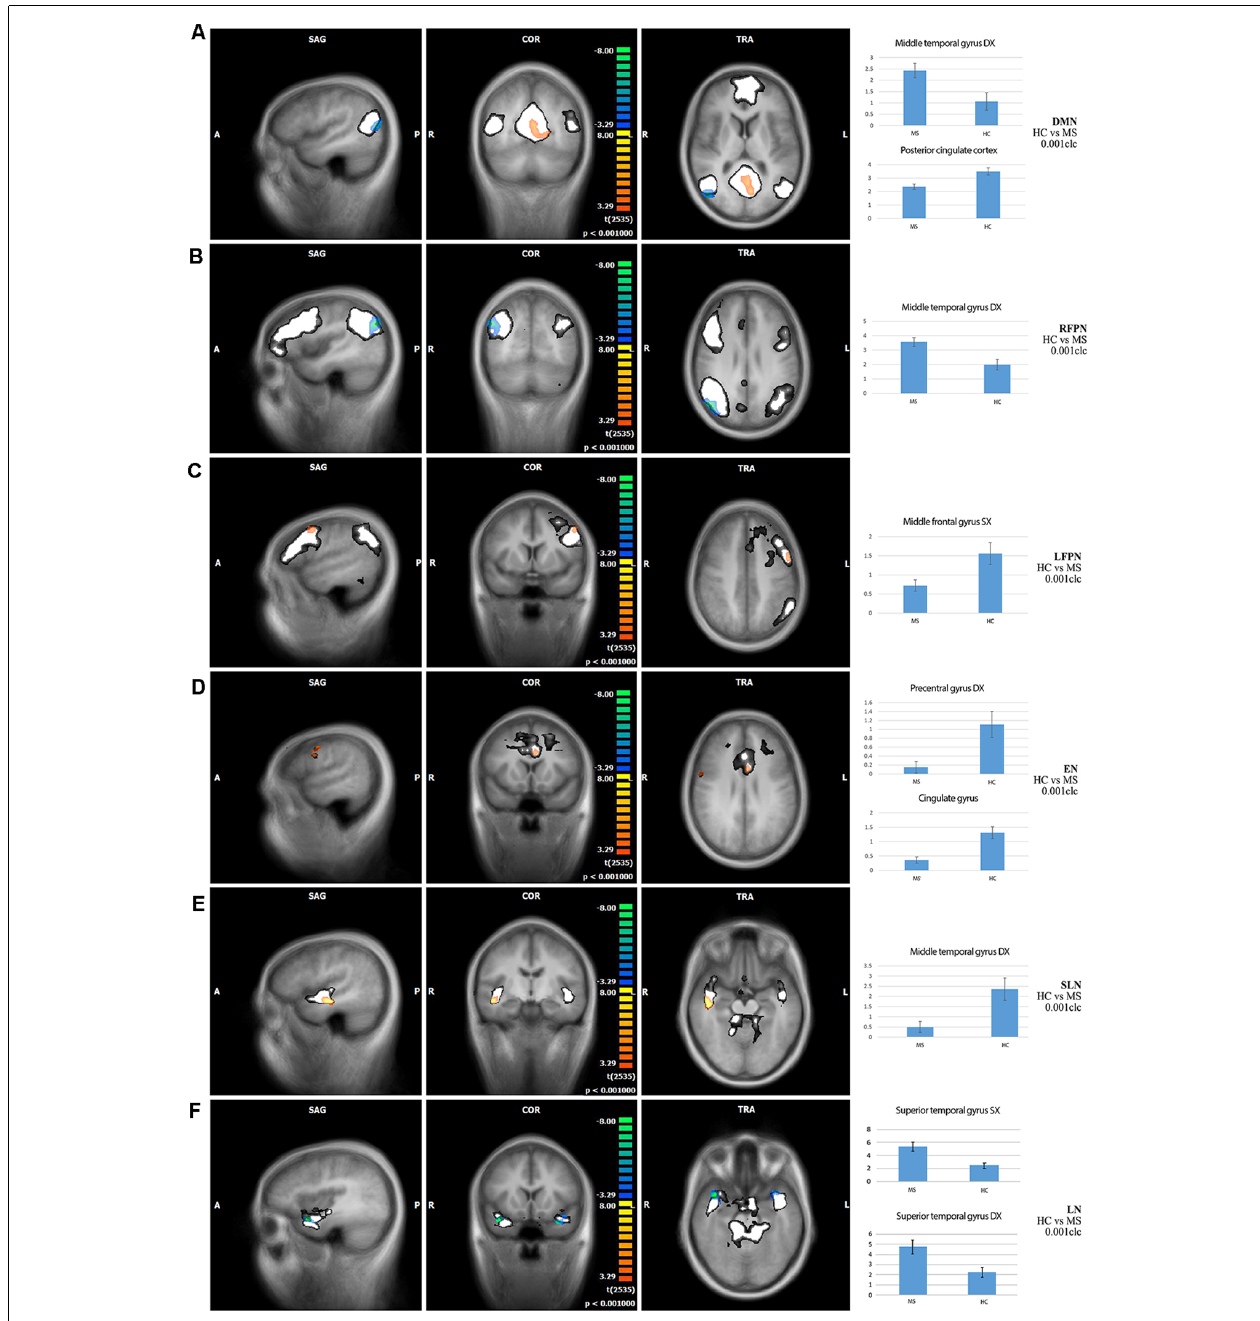
FIGURE 2 | Comparisons of resting-state functional connectivity between healthy controls (HCs) vs. MS patients (first three columns) and bar graphs showing independent component analysis (ICA) scores of highlighted clusters in HC and MS patients (fourth column) in (A) default mode network (DMN), (B) right fronto-parietal network (RFPN), (C) left fronto-parietal network (LFPN), (D) executive network (EN), (E) salience network (SLN), and (F) limbic network (LN). Color legend: hot colors: HC > MS; cool colors: MS > HC; white: explored functional brain network. A: anterior; P: posterior; L: left; R: right; S: superior; I: inferior; SAG: sagittal; TRA: transverse; COR: coronal. The clusters of significant differences ( p < 0.05, corrected) are overlaid on three orthogonal slices of the averaged normalized anatomy and on the corresponding functional brain networks (in white).